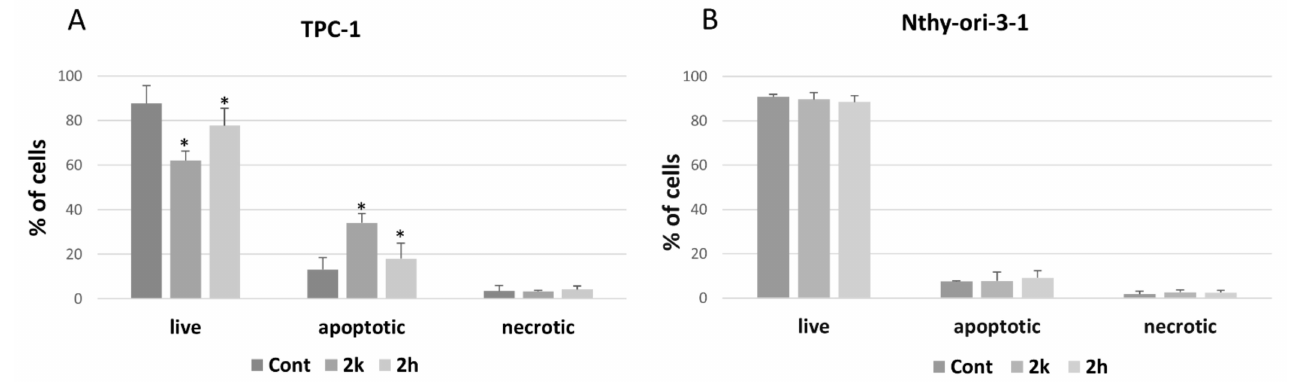
Figure 1. Detection of apoptosis by flow cytometry. ( A ): Flow cytometry histograms of Annexin V-FITC/PI staining in TPC-1cells treated with 20 µ M solutions of 2k and 2h . ( B ): Flow cytometry histograms of Annexin V-FITC/PI staining in control cells treated with 20 µ M solutions of 2k and 2h . The results shown represent the mean ± SD of three independent experiments. Significant differences between untreated vs. each treated cells are indicated by * p <